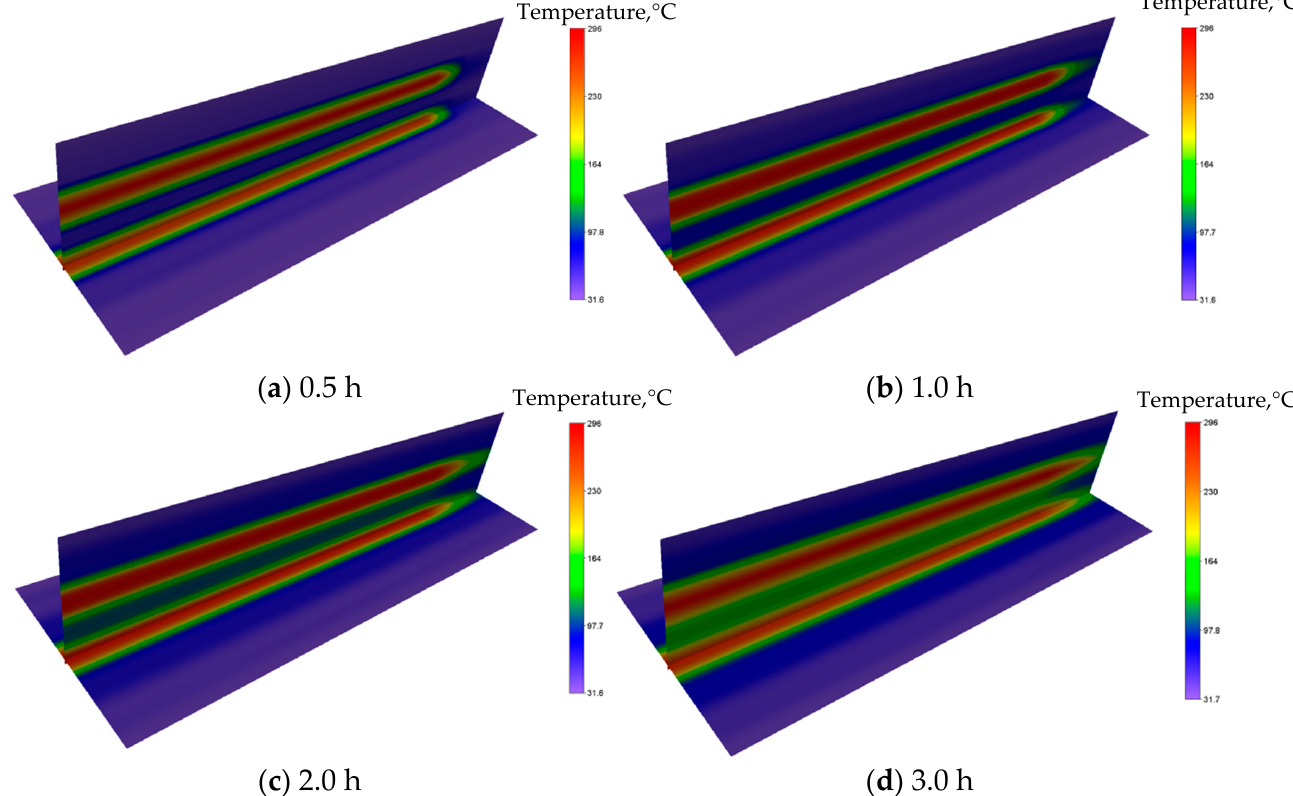
Figure 3. Temperature fields of SAGD start-up by electrical heating. h means hours.